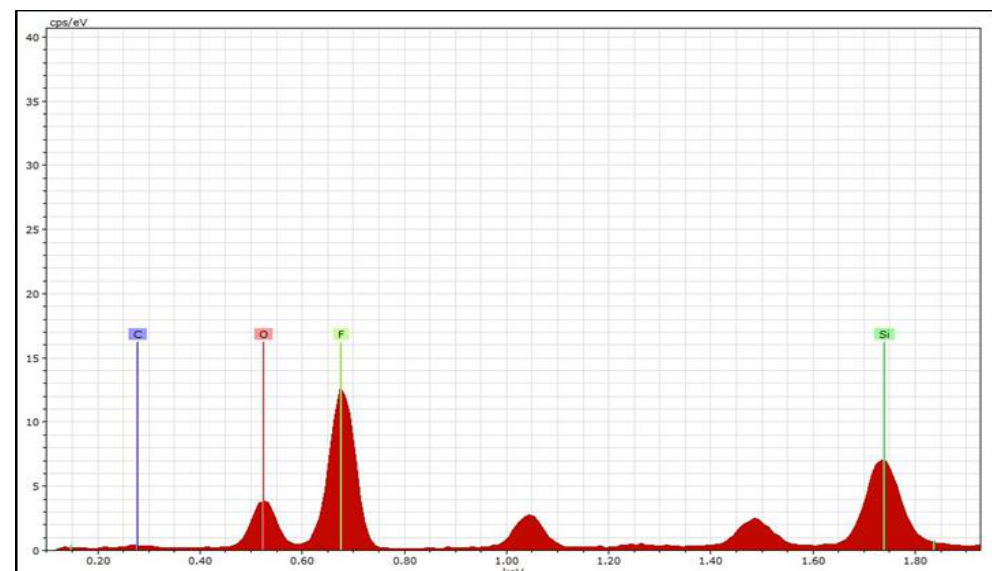
Fig.9: EDX spectra of sample b. Table 2: Composition of elements for the samples using EDX. Elements